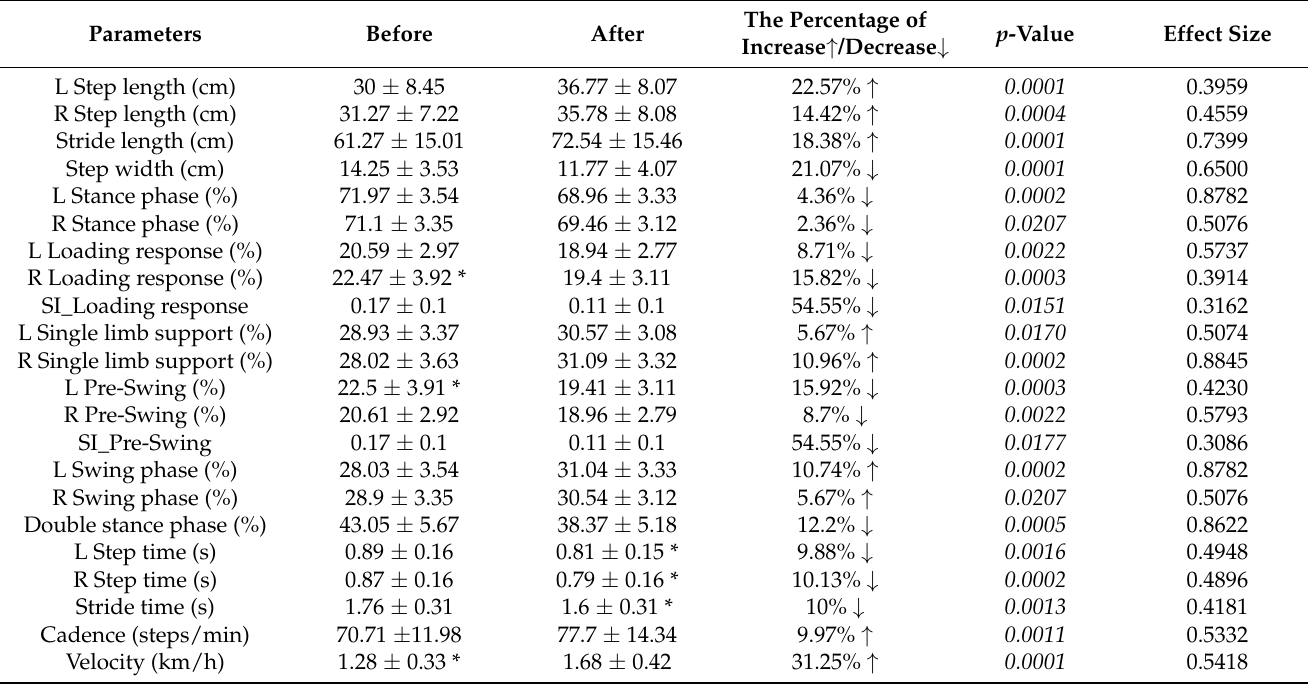
Table 6. Results (mean ± SD) of Wilcoxon test/ t -test ( p < 0.05) and effect size for comparison before and after rehabilitation within the VRG group for spatiotemporal parameters.